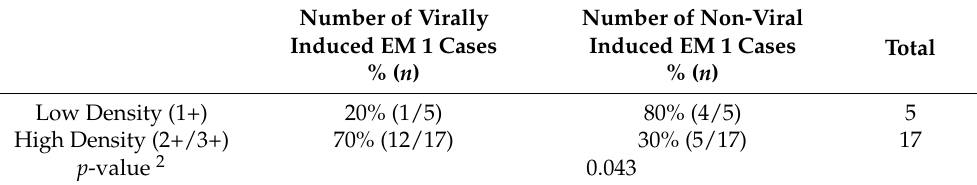
This table shows the results from the statistical analysis using the Pearson Chi- Square method. Number of Virally Number of Induced EM 1 Cases